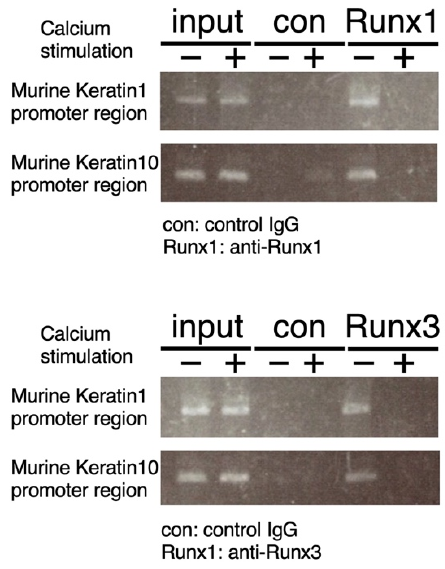
Figure 4. Chromatin immunoprecipitation (ChIP) of Runx1/Runx3 with keratin 1 and keratin 10